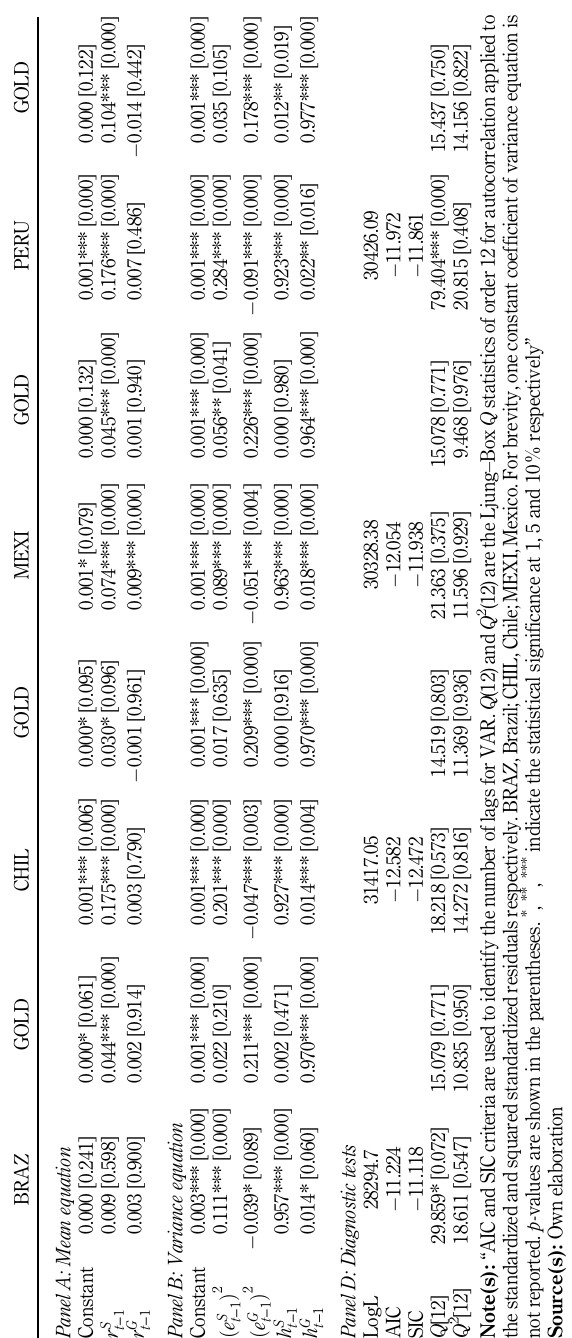
Table 3. Estimates of bivariate VAR-BEKK-GARCH for gold assets and Latin American markets during full- sample